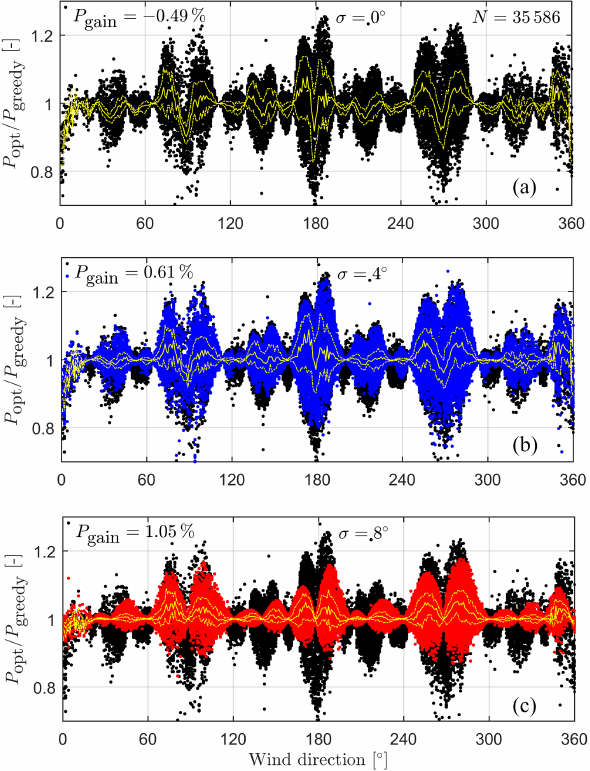
Figure 12. Test case B: evaluation of the relative power gain over the estimated wind direction ϕ est from the measured time series of 5min averaged wind direction during approx. 5 months. The yel- low plot marks the median of the power gain for the respective wind direction and the dashed yellow plot above and below the me- dian are the upper and lower quartiles, respectively. (a) Conven- tional wake deflection (black), (b) and (c) robust wake deflection for σ = 4 (blue) and σ = 8 ◦ (red),